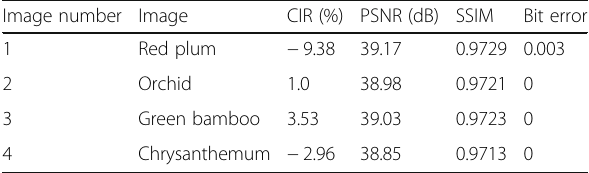
Table 3 Experiments for different images when quality is 90 Image number Image